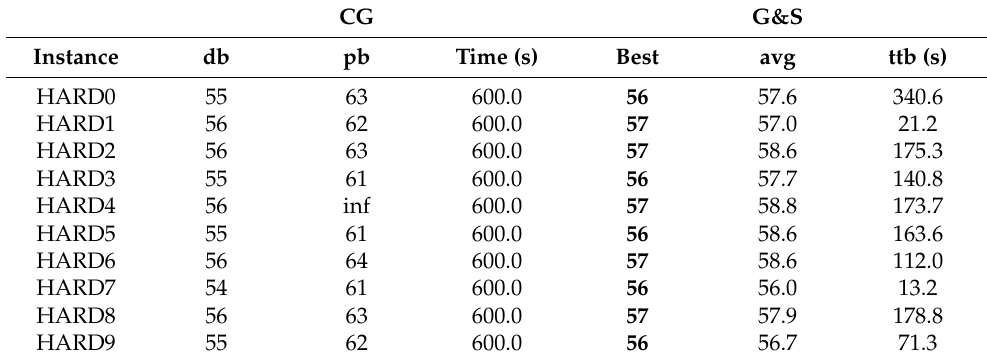
Table 4. Results for the set of instances of class hard10 .